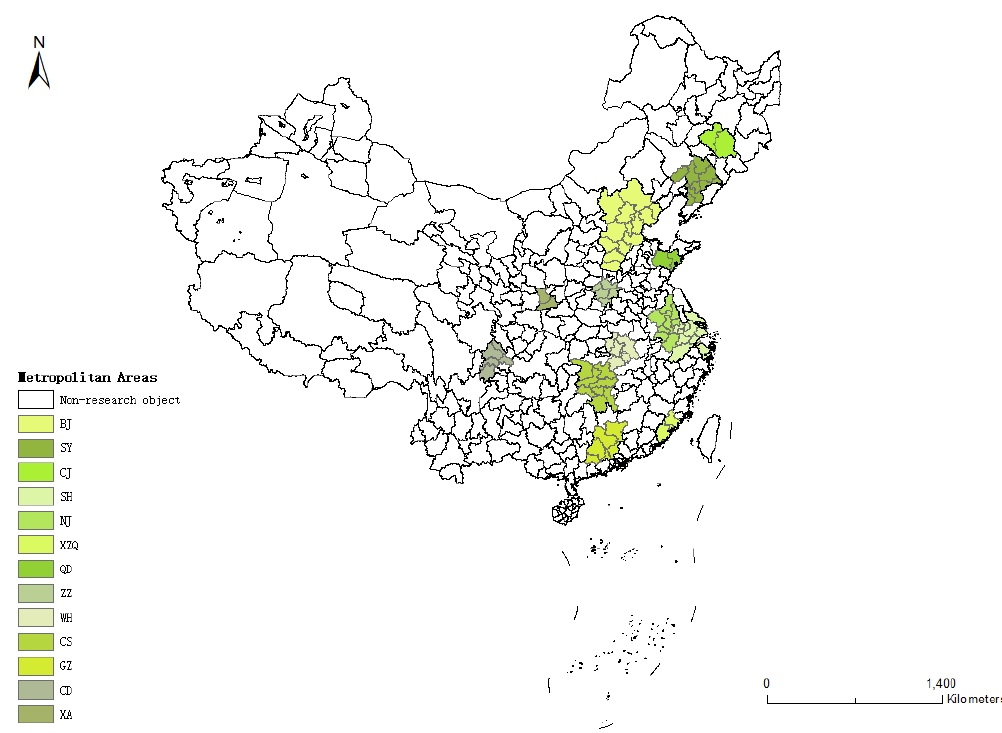
Figure 1. Distribution of the metropolitan areas.